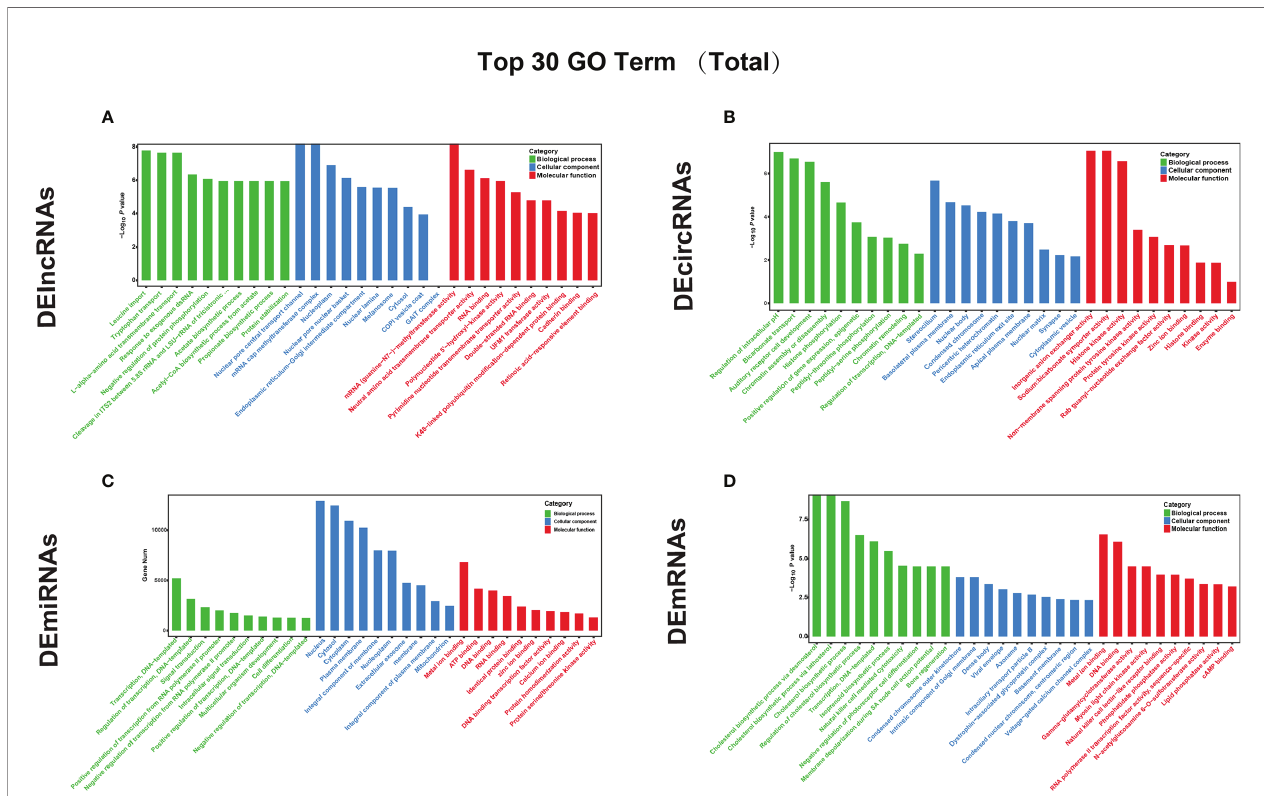
FIGURE 3 | GO annotation was performed to analyze the functions of the top 30 DEGs. GO functional analyses of the top 30 (A) DElncRNAs, (B) DEcircRNAs, (C) DEmiRNAs, and DEmRNAs (D) between untreated and GA-Me-treated HCT116 cells. The x-axis represents the GO categories, and the y-axis represents the – log 10 p value of the